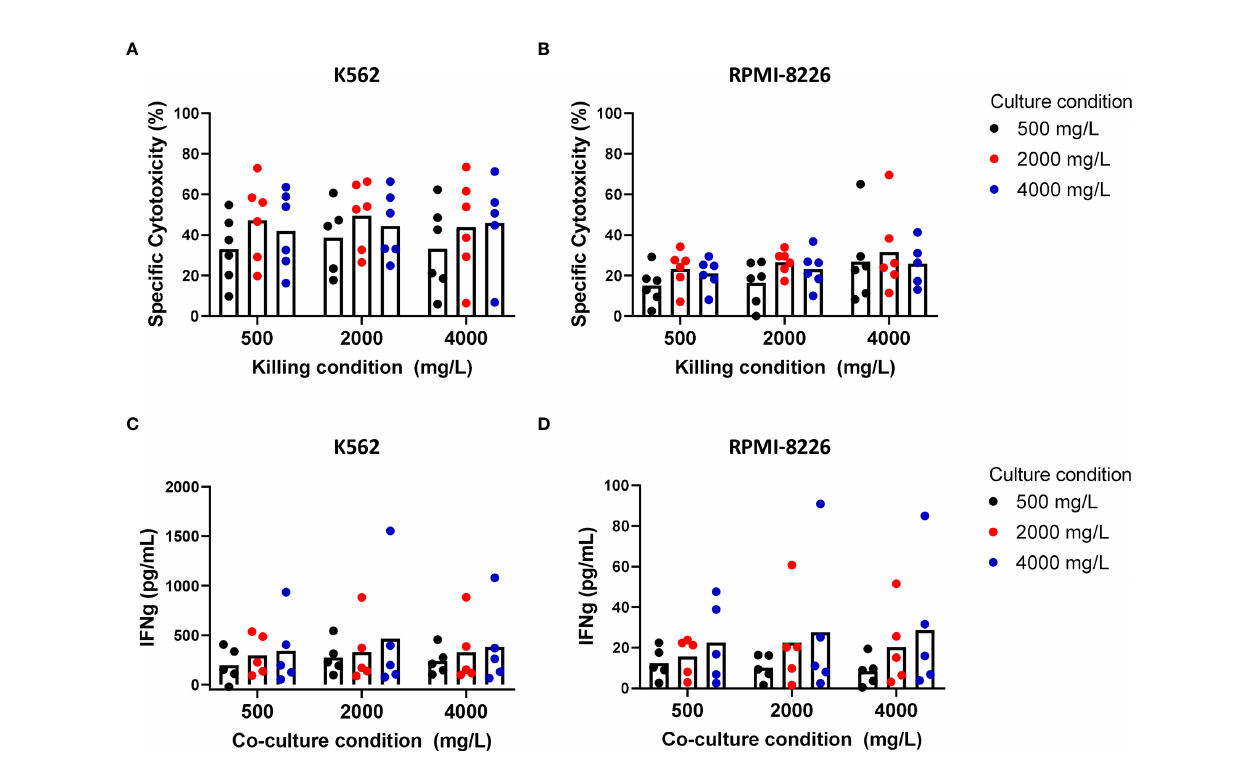
FIGURE 3 | Short-term and long-term exposure to low or high glucose levels do not reduce effector functions of expanded NK cells. NK cells were expanded with 2000 mg/L glucose and subsequently cultured in different glucose concentrations for 4 days (culture condition) followed by a 4h cytotoxicity assay (killing condition) with K562 cells or RPMI8226 cells at 1:1 E:T ratio in different glucose concentrations. Tumor cells killed by NK cells are denoted as percentage speci fi c cytotoxicity (A, B) . After the co-culture with tumor cells, supernatants were collected and analyzed for secretion levels of IFN g by ELISA (C, D) . Bars show the average of n=5-6 donors in individual experiments. For none of the conditions a p-value <0.05 was